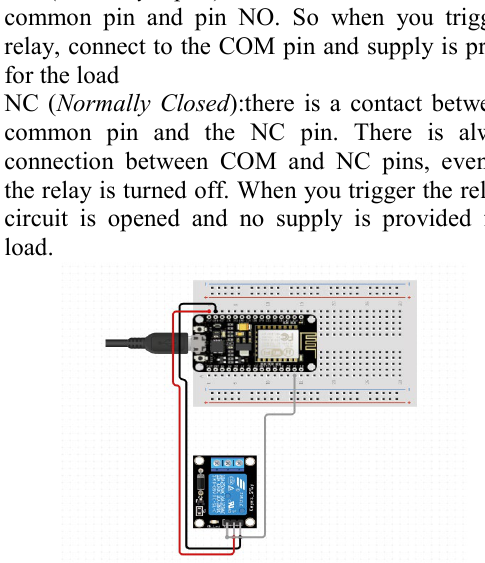
Figure 7. Application